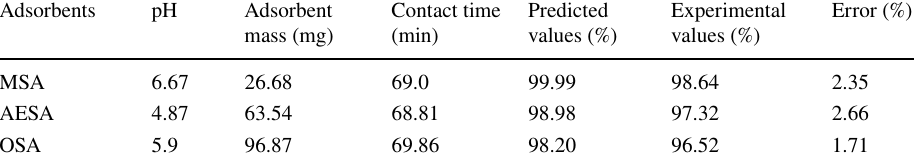
Table 9 Validation of the model predicted using desirability function